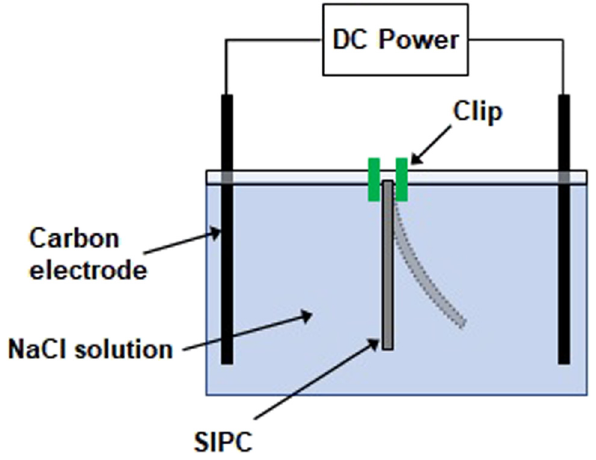
Figure 2: Illustration of the experimental setup for the electro - mechanical response